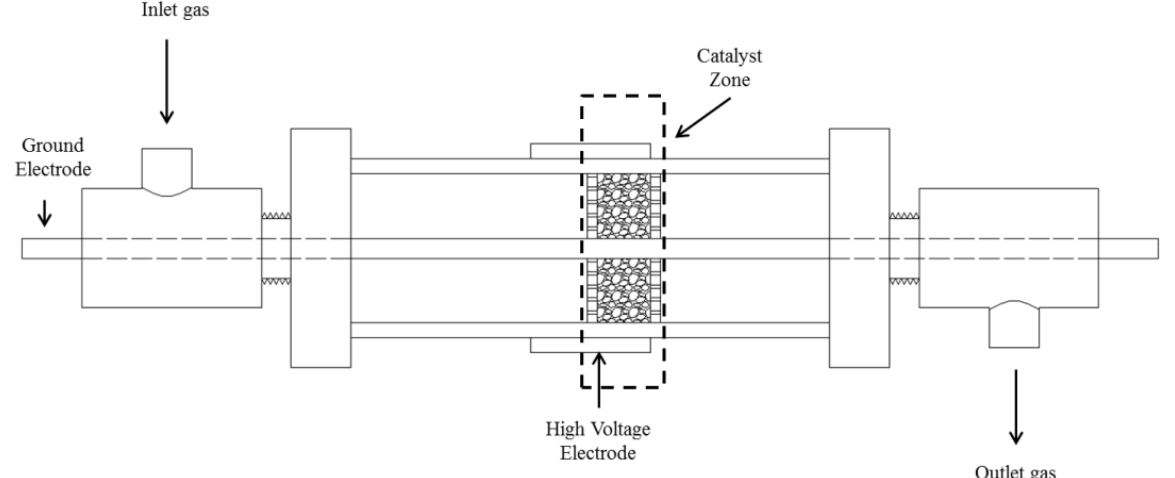
Figure 2. Schematic diagram of the DBD reactor.